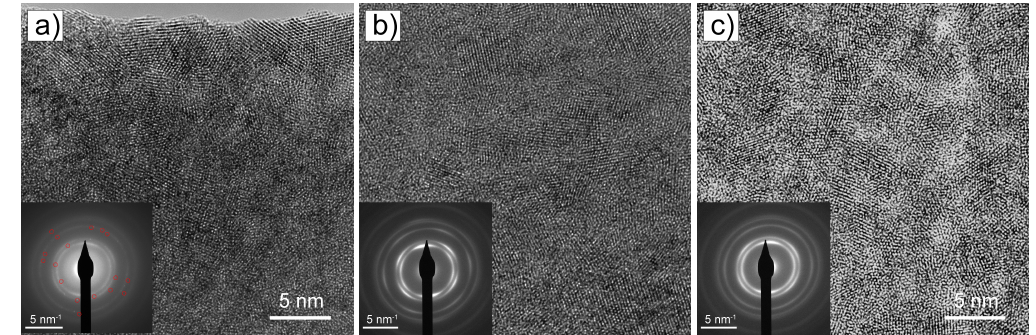
Figure 11. HRTEM images of ( a ) stationary sample with 25 at.% of Ta, 38 at.% of B and 37 at.% of C; ( b ) stationary sample with 33 at.% of Ta, 33 at.% of B and 34 at.% of C; ( c ) sample performing 1-axis rotation with 29 at.% of Ta, 36 at.% of B and 35 at.% of